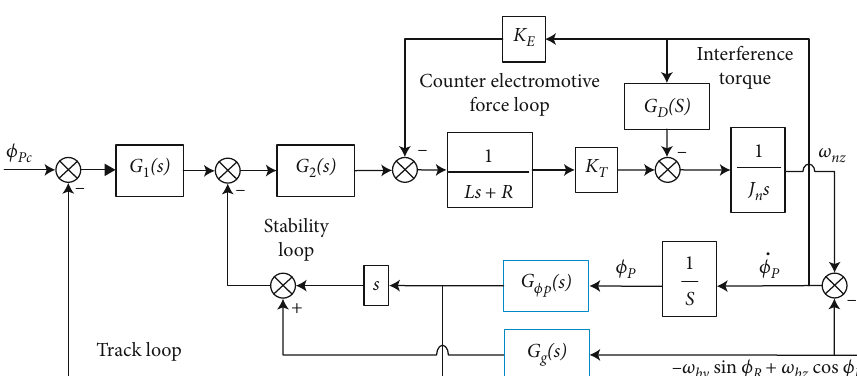
Figure 4: DRR model of the pitch